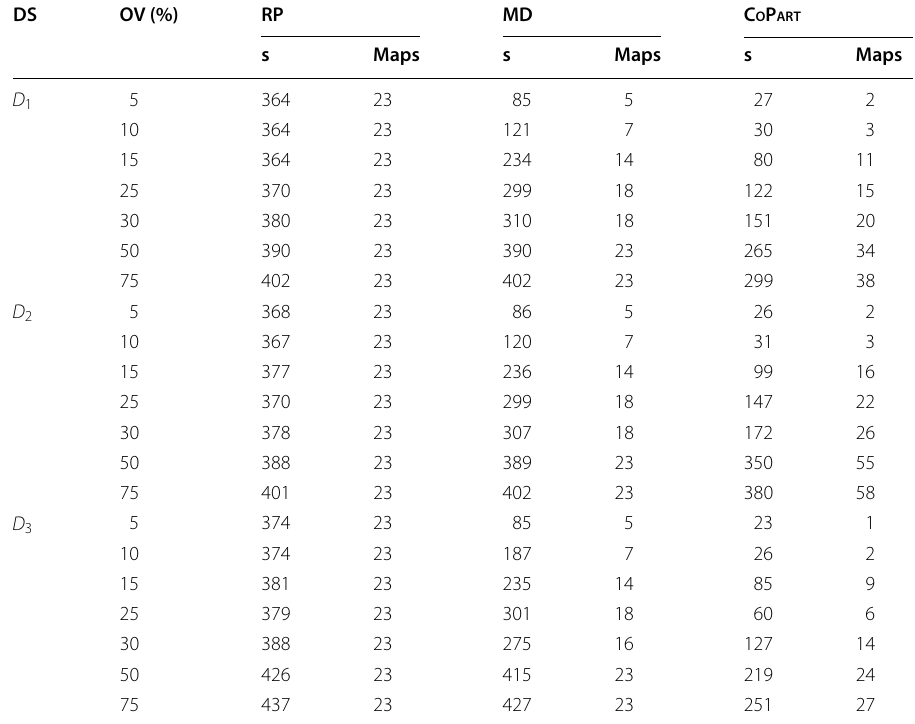
Table 4 Results of the range query experiments